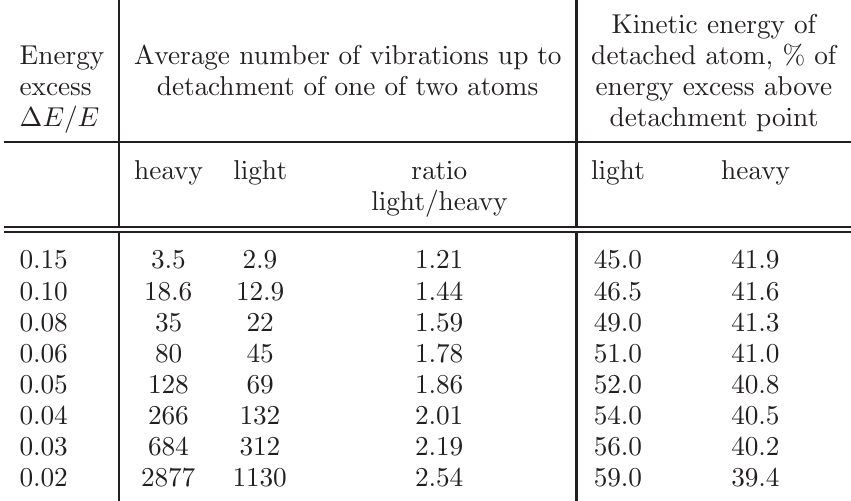
Kinetic energy of Energy Average number of vibrations up to detached atom, % of excess detachment of one of two atoms energy excess above Δ E/E detachment